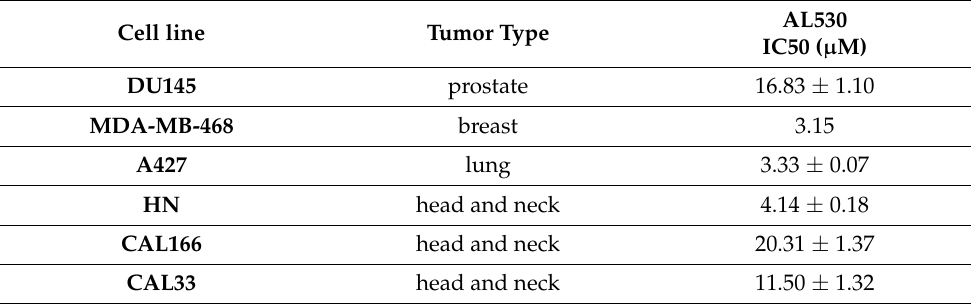
Table 1. In vitro IC50 determination of AL530 in a panel of cancer cell lines.